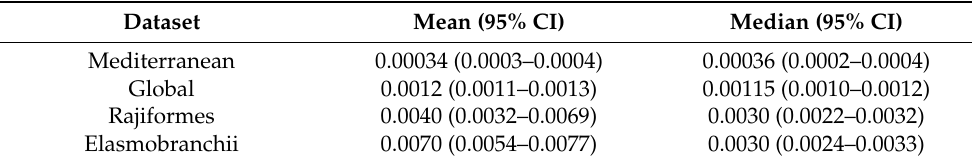
Table 3. Mean and median values, with their 95% confidence intervals (CI), of genetic diversity (nucleotide diversity) for the COI (Cytochrome C Oxidase subunit I) mitochondrial gene fragment estimated for the Mediterranean and global (Atlantic-Mediterranean) populations of Raja clavata and for Rajiformes and Elasmobranchii